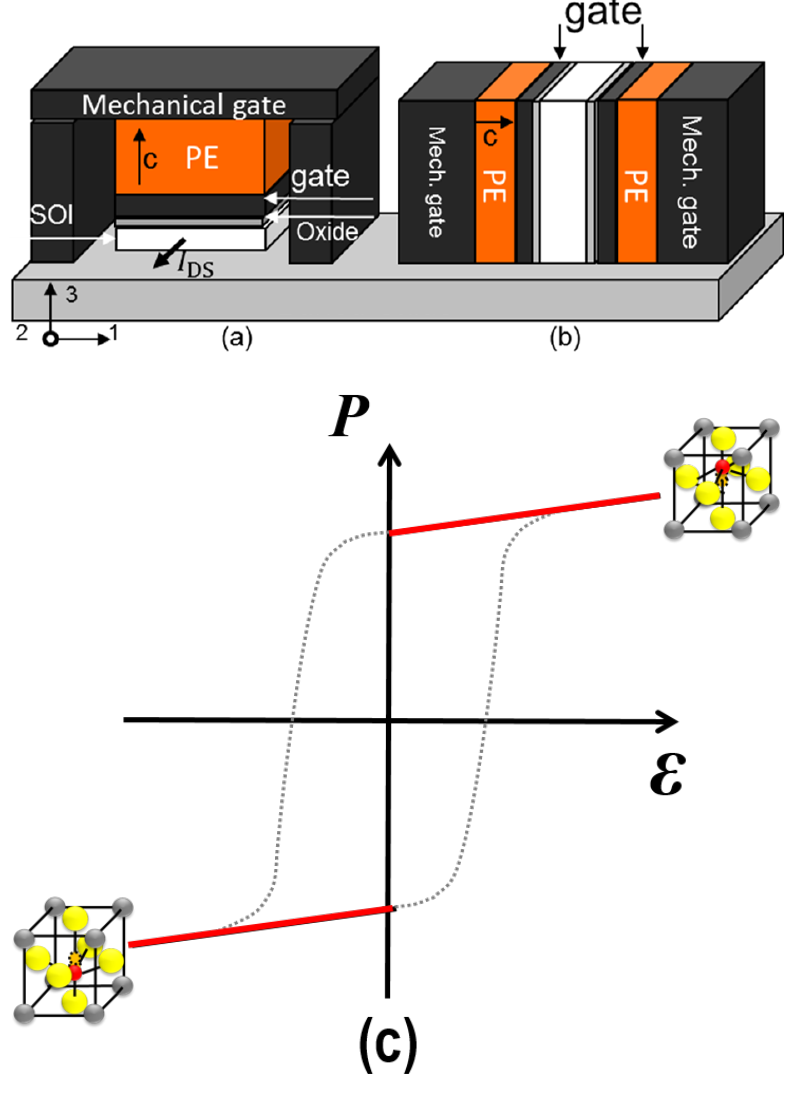
Figure 5. ( a , b ) schematic cross-section of the originally proposed π -FET (after [15]); ( c ) the highlighted operational regime of the π -FET which is outside the P - E